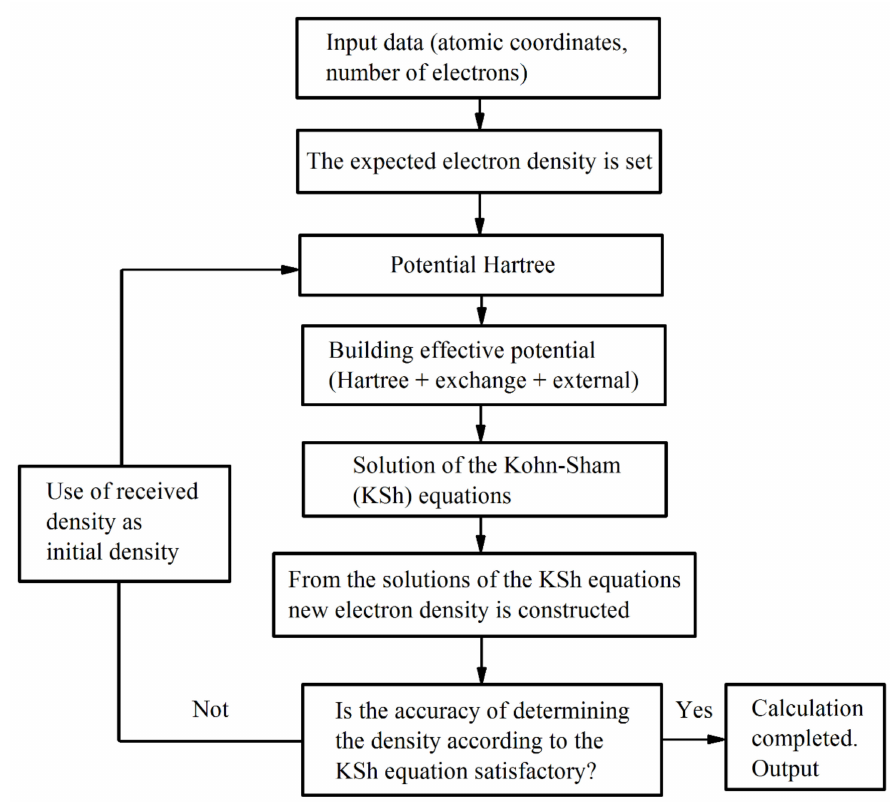
Figure 2. Block diagram of the calculation algorithm of the density functional theory